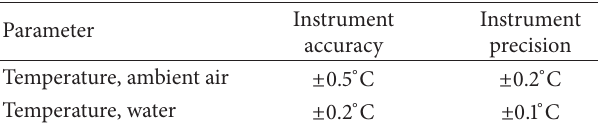
Table 3: Accuracy and precision of instruments for temperature